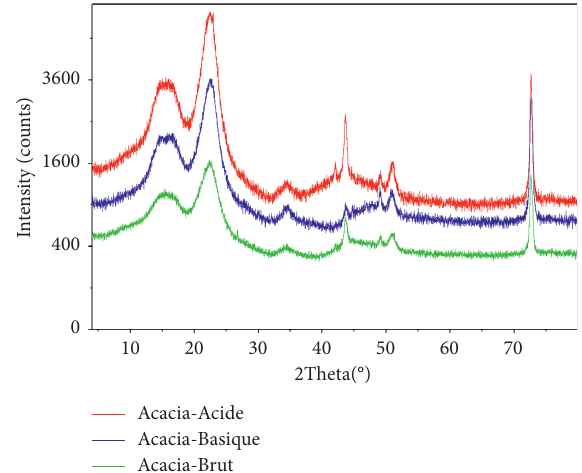
Figure 4: DRX diagram of raw acacia, A-HCl, and